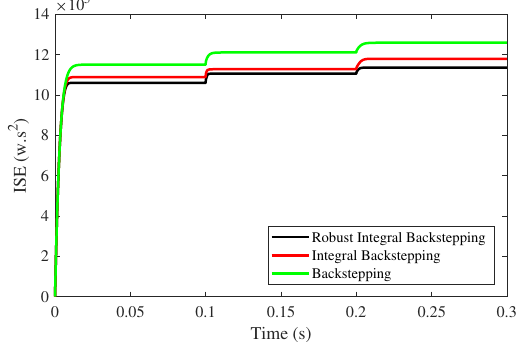
Figure 25. ISE for multiple uncertainties under varying irradiance and